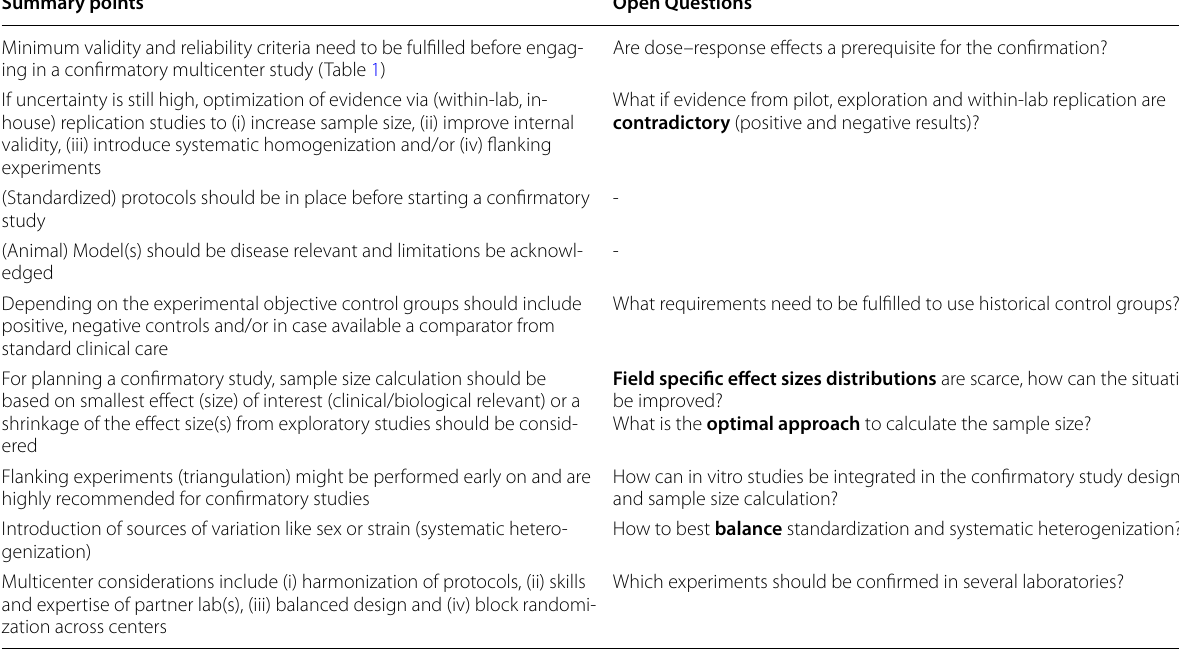
Table 2 Summary points and recommendations for the conduct of a confirmatory multicenter study including open questions that require further discussion and will be subject matter of future